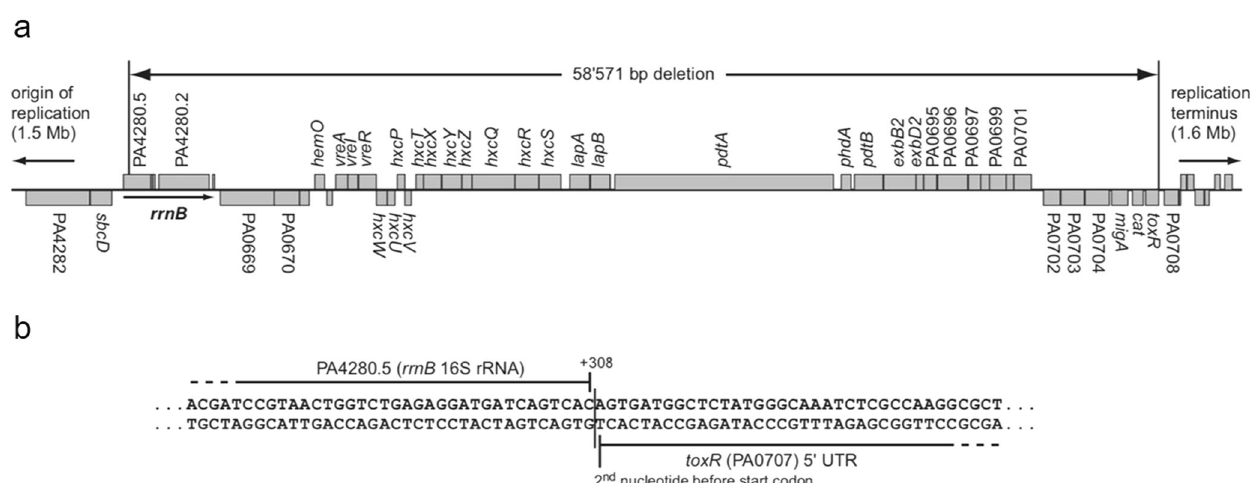
Fig. 2 Genetic organization of the 59Kb chromosomal deletion absent from PAO1-N. a Genetic organization of the ~59 kb deletion in P. aeruginosa PAO1-N subline. b The deletion spans from the 308 th bp of the 16 S rRNA gene PA4280.5 until the 2nd bp before the start codon of toxR .